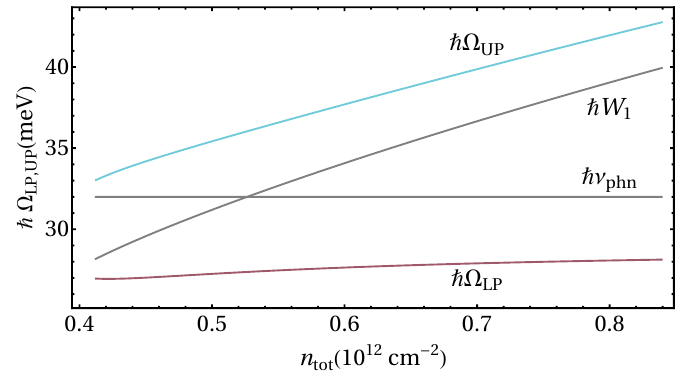
Figure 3. (Color online) Phonon and MSB free energies (¯ hW 1 and ¯ h ν phn ) and coupled eigenmodes (¯ h Ω LP,UP , in purple and blue) as a function of the total doping density n tot in the quantum well.